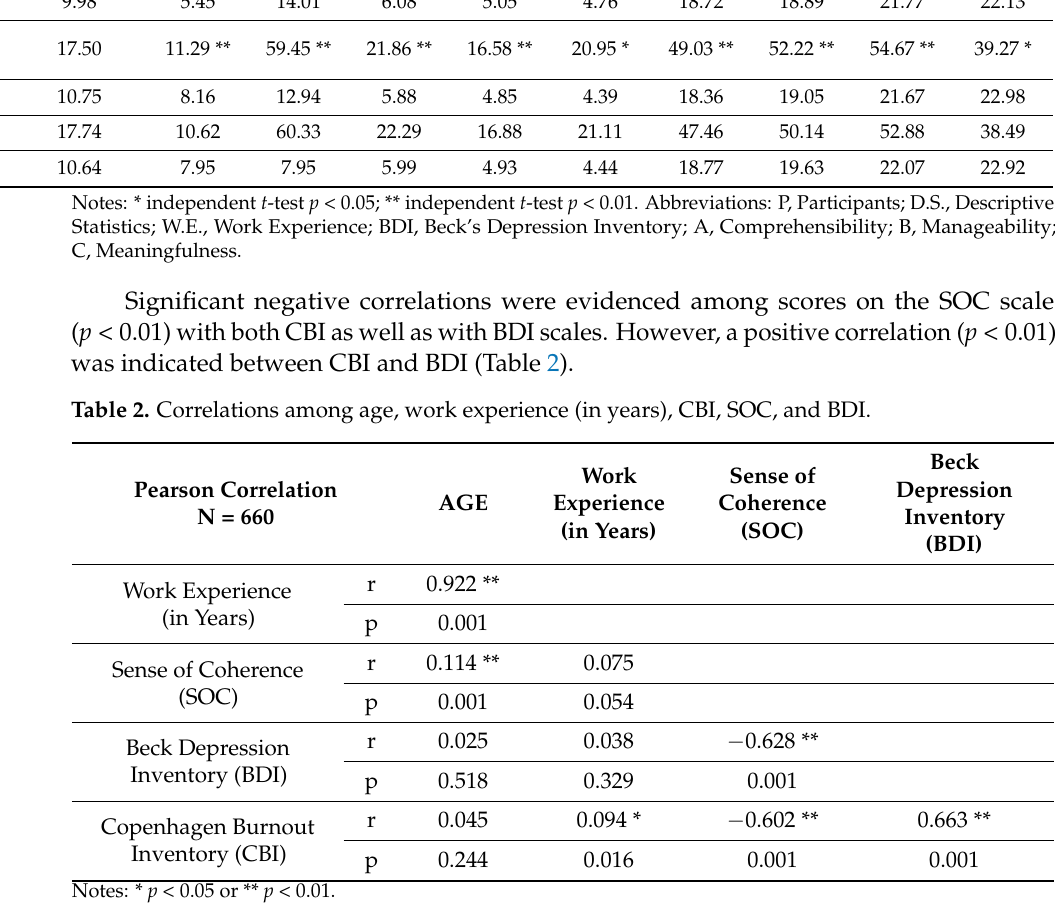
Table 1. General characteristics of nursing staff and SOC/CBI scores with regards to gender. Sense of Coherence Questionnaire Copenhagen Burnout Inventory (SOC) (CBI)